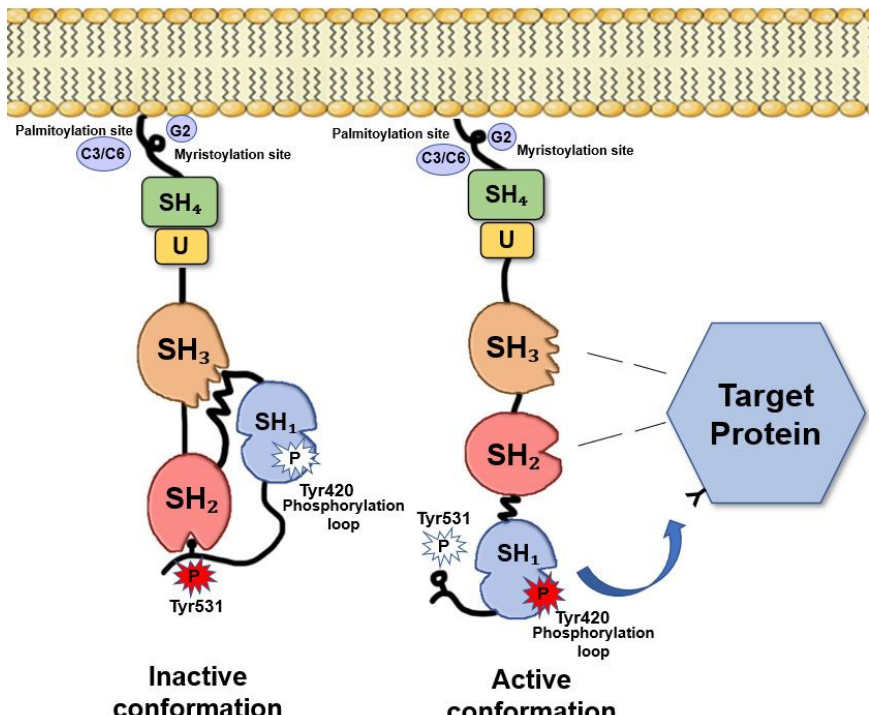
Figure 1. Fyn structure. The SH4 domain, is a membrane-targeting domain containing signals for the appropriate subcellular localization and membrane attachment of Fyn [21] . This domain consists of an extreme N -terminal ‘Met-Gly-Cys’ motif followed by a polar region [9,22] . The N -terminal Gly2 seems to be an absolute requirement for myristylation. Cys3 and Cys6, are both palmitoylated via a thioester linkage [23] , thus, allowing Fyn anchors to the plasma membrane [24–26] . Between the SH4 and the SH3 motifs, there is a short region called “the unique region” that it is likely to be required for the subcellular localization of Fyn [27] . The SH3 motif constitutes a small domain of 50 amino acids containing a consensus sequence XPXXPPPXXP [28] that allows the binding to amino acid sequences rich in proline residues [29] . The SH2 domain consists of about 100 amino acids and appears to facilitate the binding to phosphotyrosine residues and to hydrophobic sequences within the cytoplasmic tails of growth factor receptors (i.e., PDGF-R, CSF-1 R) [30,31] . The catalytic domain SH1 is responsible of TK specific activity. This domain is highly conserved among Src family members [32] . The kinase domain, that catalyses the transfer of the terminal ATP phosphate group to a tyrosine residue of a target protein, shows a typical bilobed structure consisting in a small N -terminal lobe, involved in the binding with ATP, and a larger C-terminal lobe, where an activation loop (A-loop) is present. The conserved Tyr420, crucial for Src activity, is included in this domain [33] . However, the major site of phosphorylation and regulation of Fyn TK activity is the short negative regulatory tail where Tyr531 is located [32] . Adapted from Krämer-Albers et al. (2011) [34] . It is not worth that, the replacement of Tyr531 with phenylalanine is sufficient to convert Fyn protooncogene to oncogene [35,36].